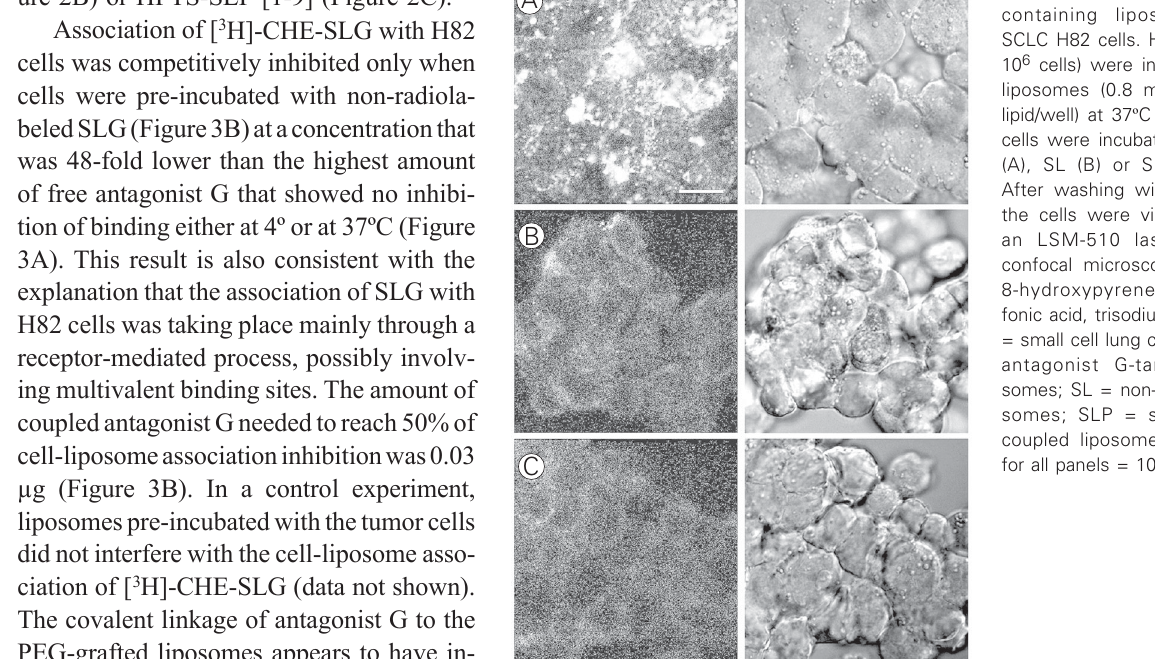
Figure 1. Association of [ 3 H]- CHE-labeled liposome formula- tions with SCLC H82 cells. H82 cells (1 x 10 6 cells) were incu- bated with different liposomal formulations (0.1-0.8 mM phos- pholipid (PL)/well) containing SL (open circles) or SLP [1-9] (inverted triangles) at 37 º C or SLG at 4 º C (lozenges) or 37 º C for 1 h (filled circles) or SL in the presence of free antagonist G at an antagonist G/phospholipid molar ratio of 1:200 (open tri- angles). Each point is the mean